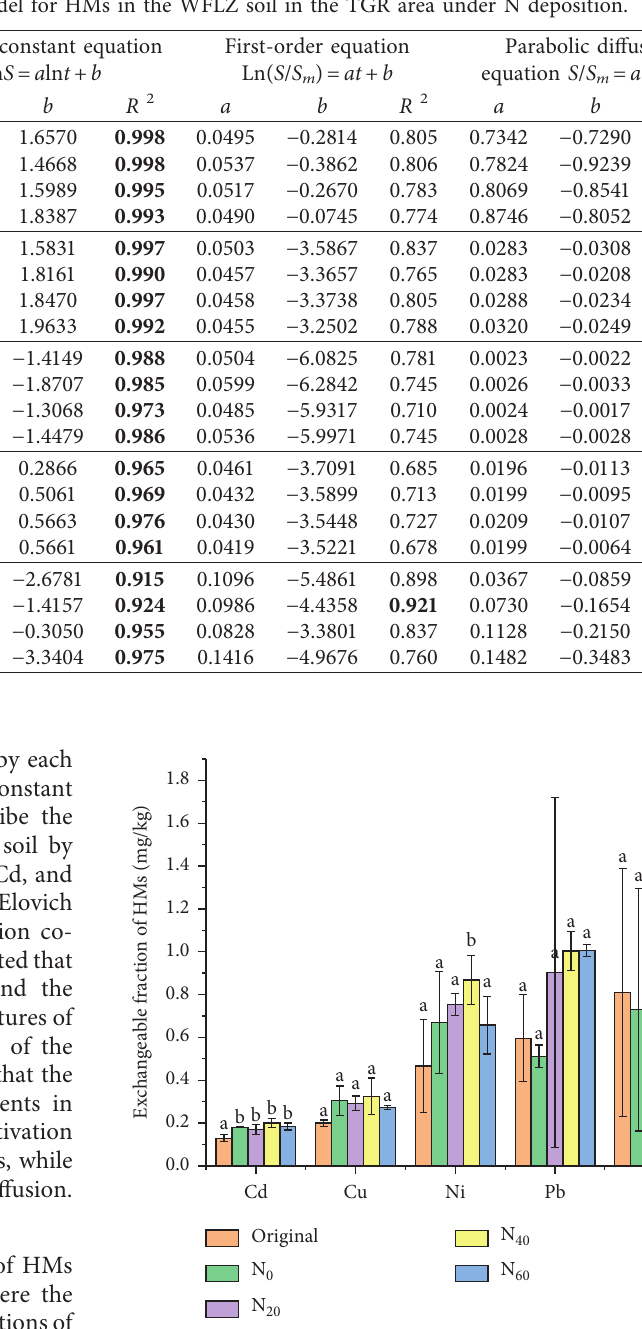
Figure 4: Changes of exchangeable fractions of HMs before (original) and after leaching (N 0 , N 20 , N 40 , and N 60